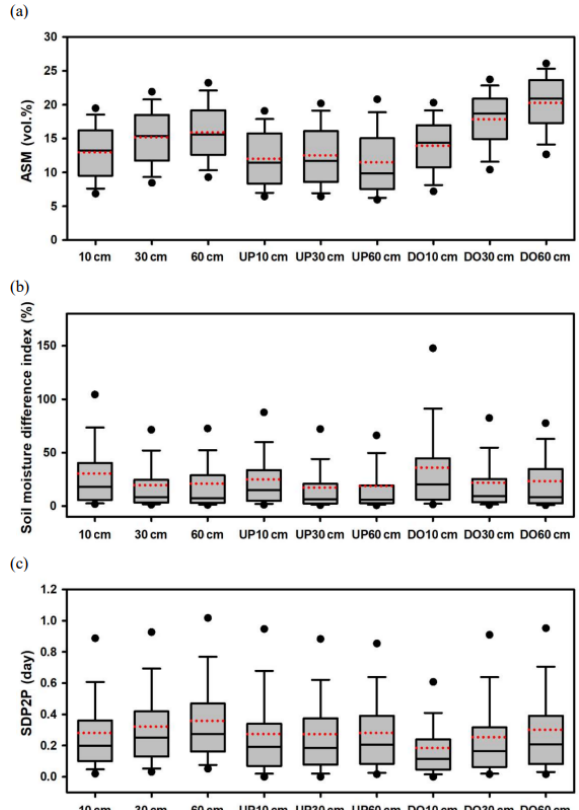
Figure 3. Box plots illustrating antecedent soil moisture (a) , soil moisture difference index (b) , and standard deviation of peak time (SDP2P) (c) of 12 time series of soil moisture.